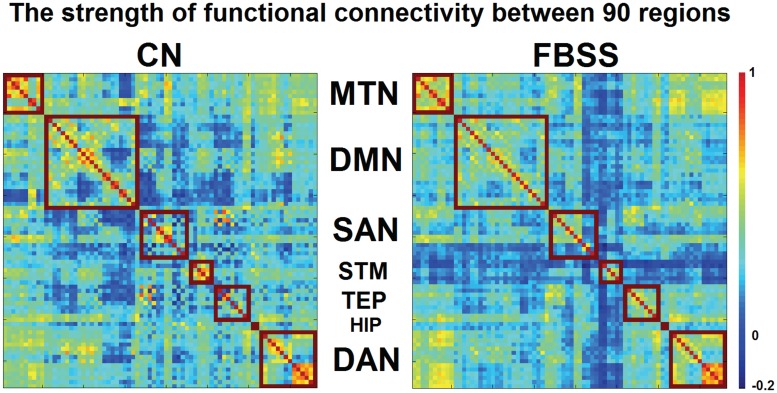
Regional-based FC between each pair of brain regions for CN group and FBSS group.A color bar (right) shows the color and associated value of FC (range from -0.2 to 1.0). Each red square contains the regions for each network.